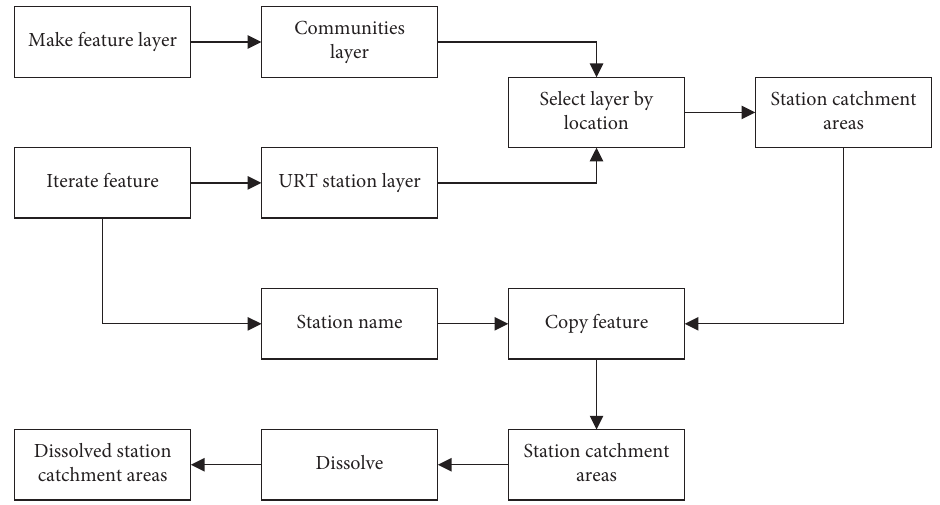
Figure 1: Process of determining the